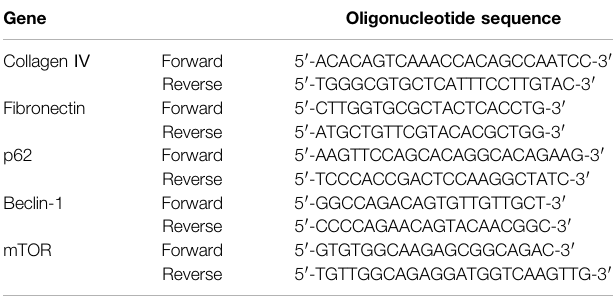
TABLE 2 | Primer sequences used for PCR. Gene Oligonucleotide sequence Collagen